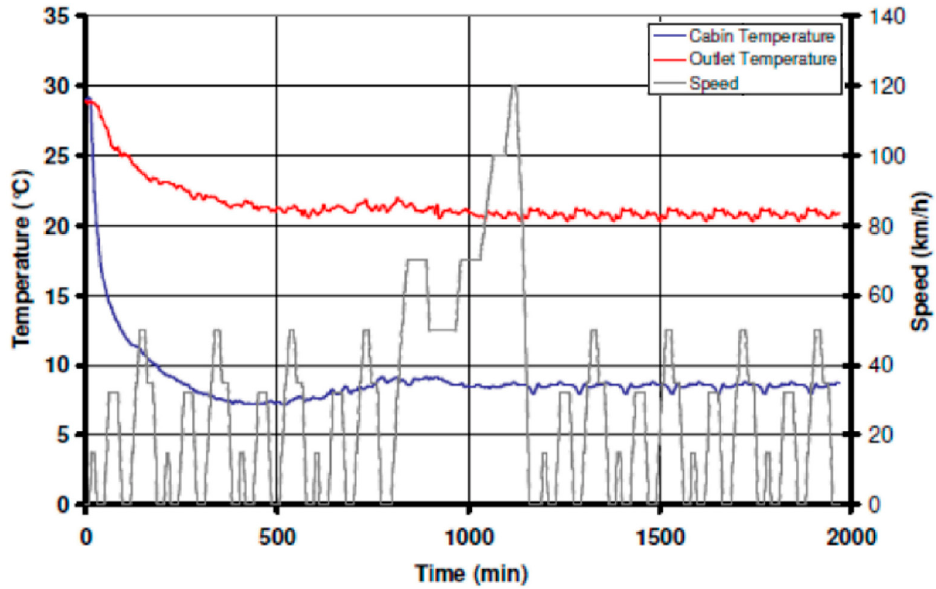
Figure 13. Engine speed and the cabin temperature variation under NEDC ‐ 2ECE mode [81].